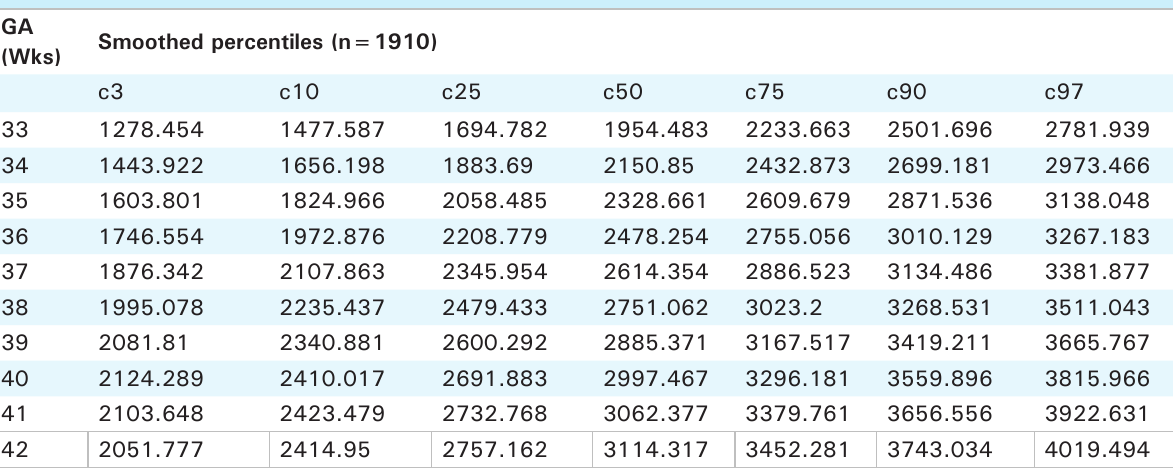
Table 2. Smoothed percentile values of birth weight for each gestation from 33 to 42 weeks.